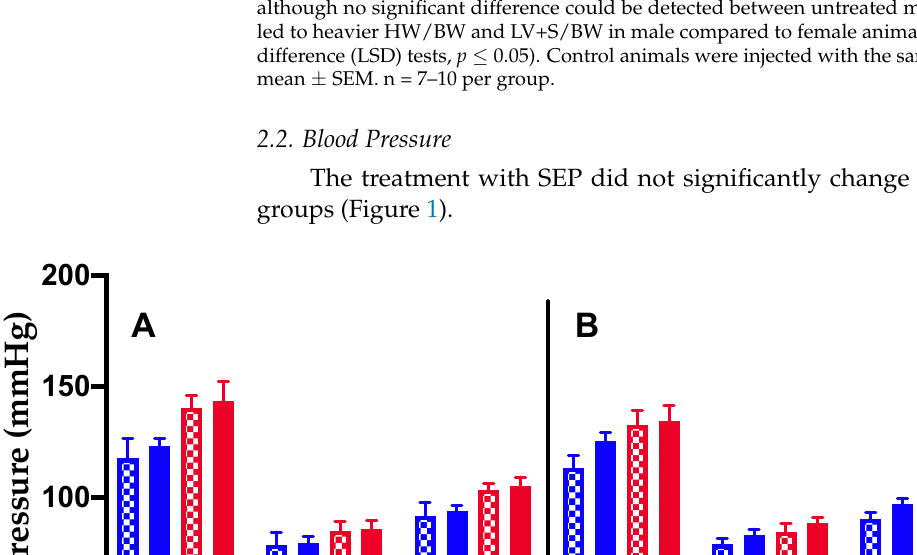
Table 1. Body weight, hematocrit and ratios of total heart and left ventricle plus septum weights to body weight. Male Female Eln +/+ Eln +/- Eln +/+ Eln +/- NaCl SEP BW: body weight, HW: heart weight, LV: left ventricle weight, S: septum weight. & significant in ‐ teraction between sex and treatment, independently of genotype (three ‐ way ANOVA, p ≤ 0.05), showing that SEP decreased hematocrit in females, not males (post hoc Fisher’s least significant difference (LSD) tests, p ≤ 0.05). $ significant interaction between sex and treatment, independently of genotype (three ‐ way ANOVA, p ≤ 0.05), showing that, although no significant difference could be detected between untreated male and female mice, SEP treatment led to heavier HW/BW and LV+S/BW in male compared to female animals (post hoc Fisher’s least significant difference (LSD) tests, p ≤ 0.05). Control animals were injected with the same volume of 0.9% NaCl. Values are mean ± SEM. n = 7–10 per group.